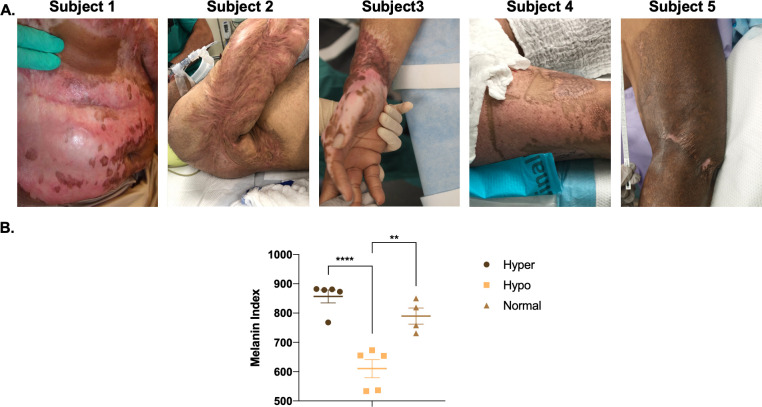
Heterogeneous dyschromia with hyper- and hypo-pigmentation develops after burn injury in patient HTS.Examples of HTS from Subjects 1–5 from Table 2 (A). SCC non-invasive skin probe was used to measure melanin in the different pigmentation phenotypes (B) (mean ± SEM, n = 5 scars). **p<0.01, ****p<0.0001.